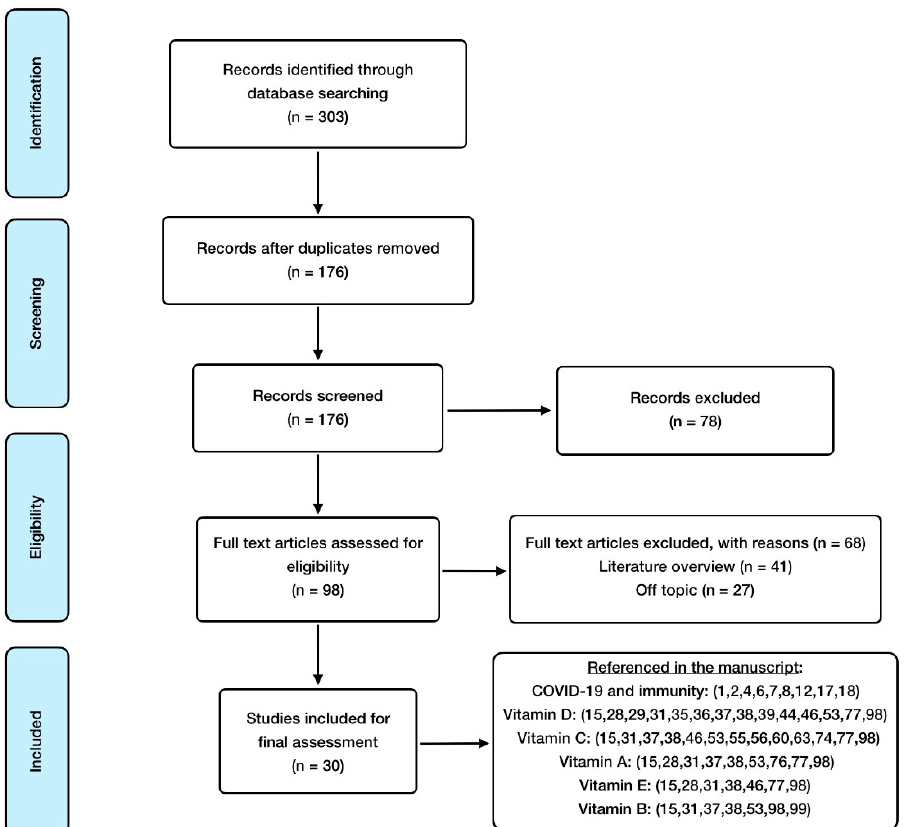
Figure 1. PRISMA flowchart summary for the manuscripts and scientific contribution selection.